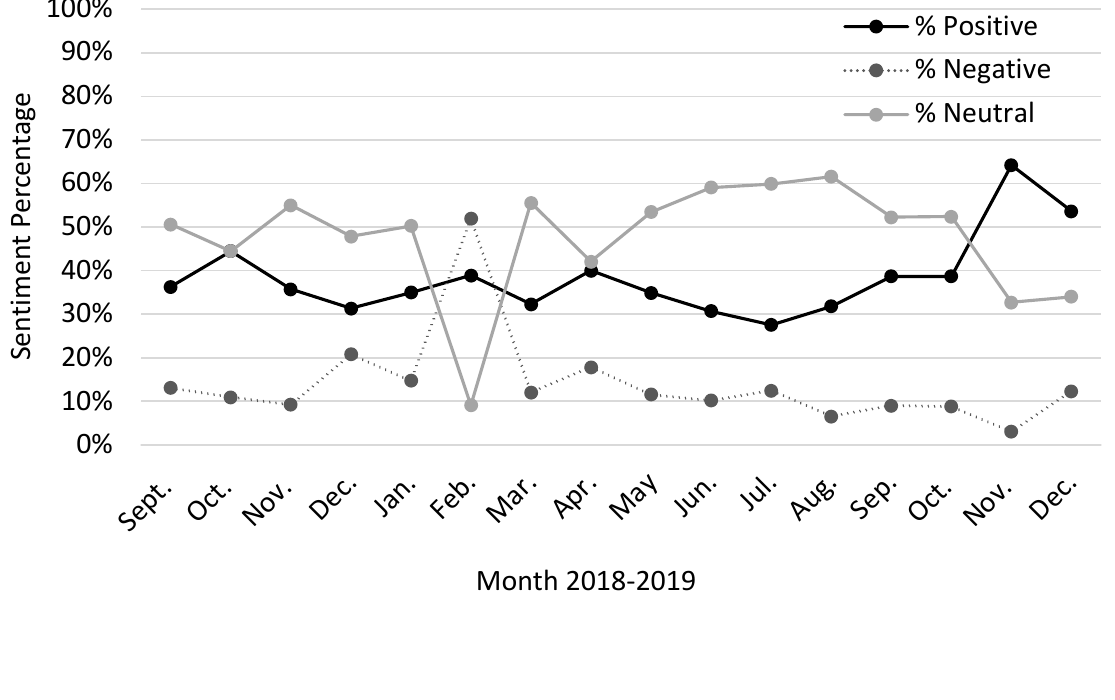
Sentiment of Gene Editing in Agriculture